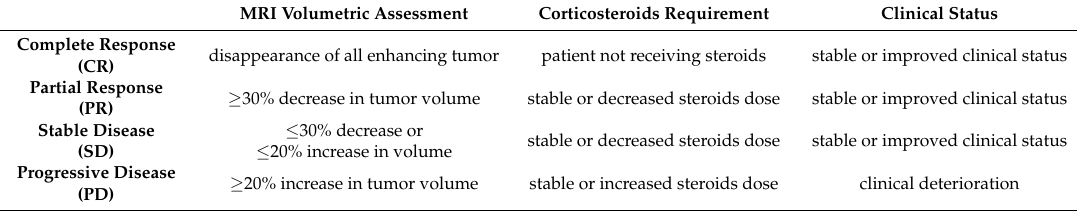
Table 7. Combined Response Evaluation System (CRES): MRI volumetric assessment implemented with clinical evaluation and the need of corticosteroid